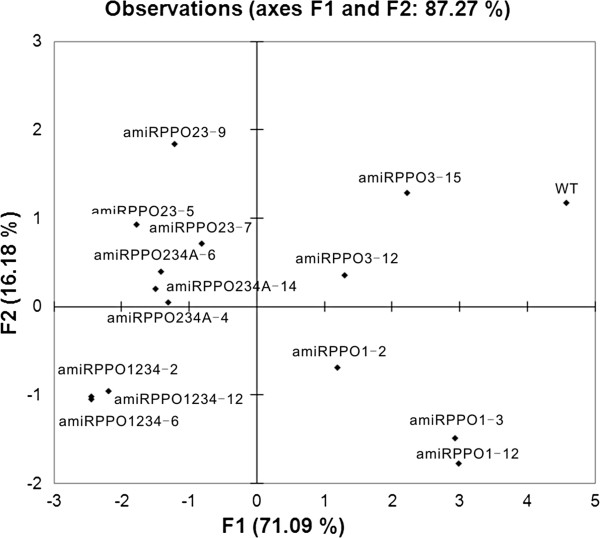
Score scatter plot of the transgenic lines and WT according to principal component analysis (PCA). The bioplot represents the first and second principle components (PC1 and PC2, eigenvalue > 1.0) produced from the PCA of 15 observations (14 transgenic lines and WT) based on seven variables, relative PPO gene expression level of StuPPO1, StuPPO2, StuPPO3 and StuPPO4, RPR, RPPO and RBR. Each line is represented by one dot. Points that are close together correspond to observations that have similar scores for the components displayed in the plot.